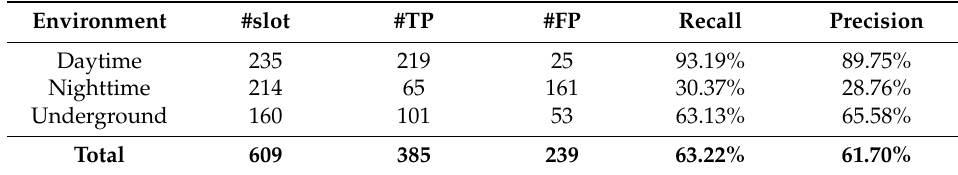
Table 3. Performance of the method in [4].